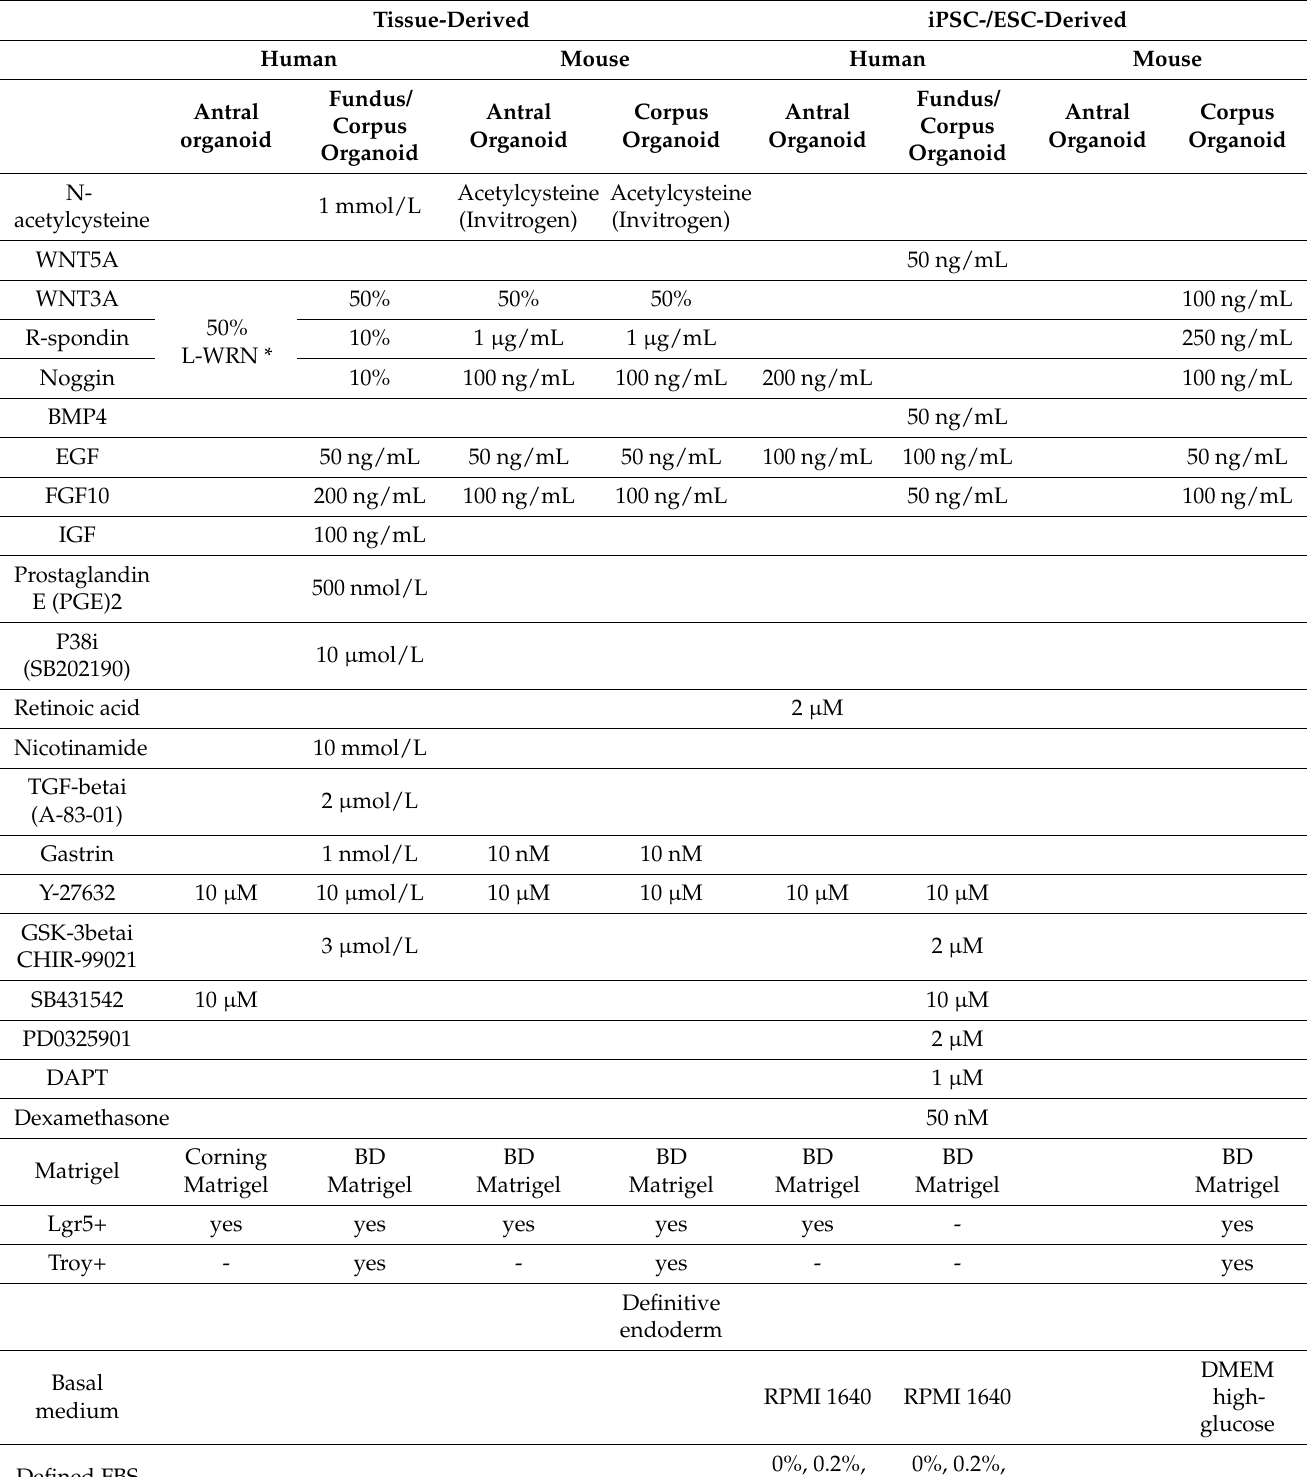
Table 2. Cont. Tissue-Derived iPSC-/ESC-Derived Human Mouse Human Mouse Fundus/ Fundus/ Antral Corpus Antral Corpus Antral Antral Corpus Corpus Organoid Organoid Organoid Organoid organoid Organoid Organoid